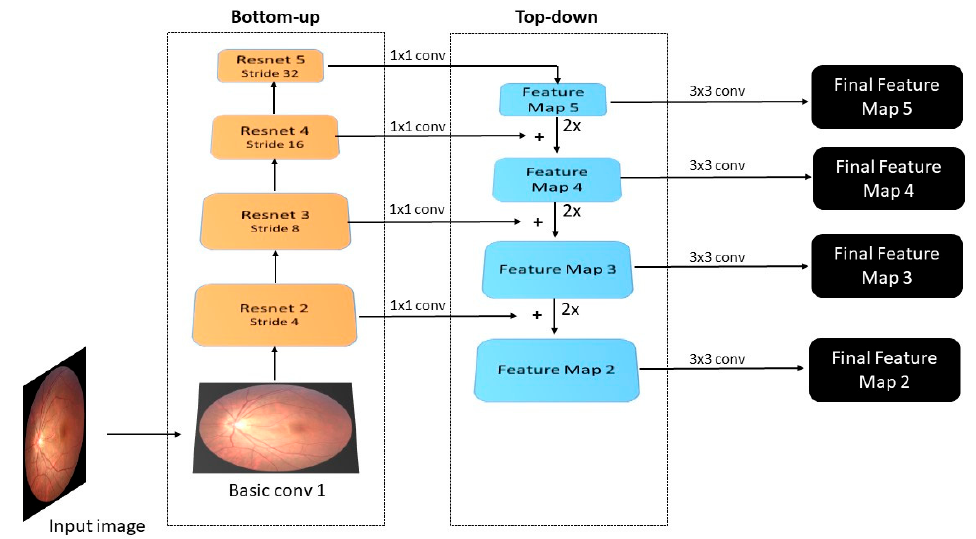
Figure 2. Detailed design of Resnet 50 + FPN backbone.